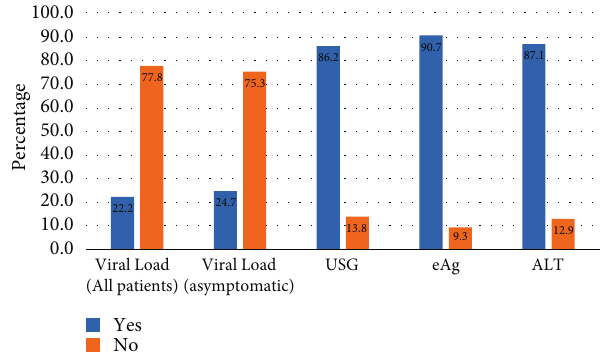
Figure 2: Proportion of patients who were able to undertake diagnostic investigations.